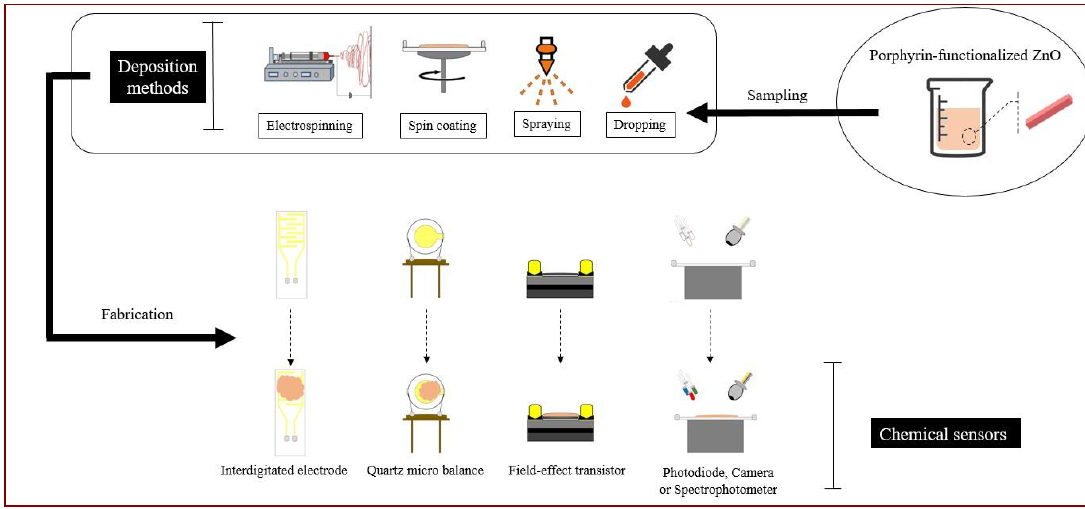
Figure 2. Different routes for the fabrication of devices based on porphyrin-functionalized ZnO.